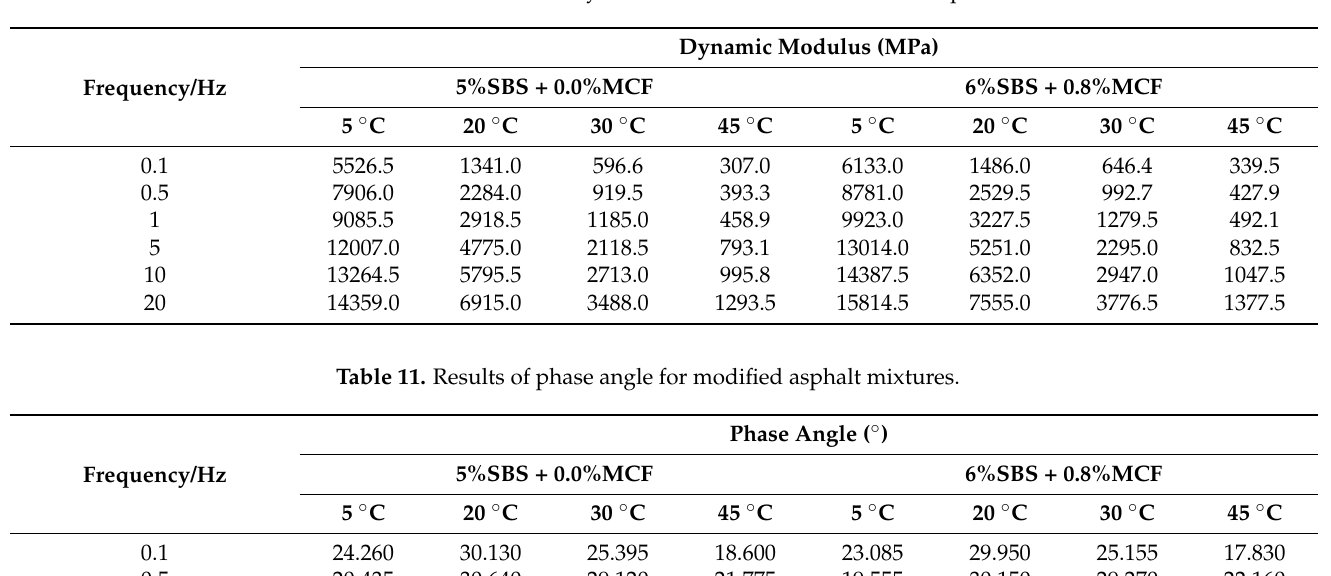
Table 10. Results of the dynamic modulus test for modified asphalt mixtures.